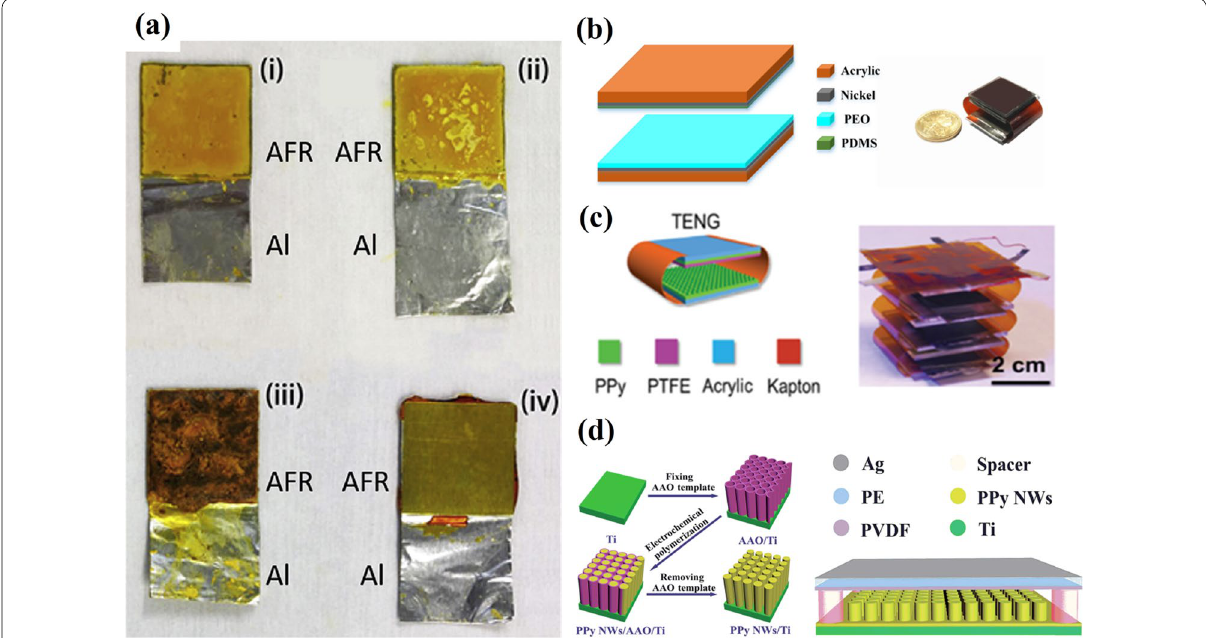
Fig. 3 Tribo-positive polymers for the TENG fabrication: a the digital photographs of the AFR sample at various stages of preparation with (i) corresponding to as-prepared uncured sample deposited on an Al foil, (ii) corresponds to washed sample while (iii) and (iv) correspond to the dried and fully cured, hot-pressed AFR samples, respectively (Reproduced with permission from Ref. [31]), b a schematic diagram and a photo of the TENG using PEO and PDMS films as the positive and negative tribo-materials, respectively (Reproduced with permission from Ref. [33]), c a schematic diagram and a photo of three stacked PPy-based TENG (Reproduced with permission from Ref. [34]), d a schematic depiction of PPy NW preparation by electrochemical polymerization with AAO as the template and schematic diagram of the final TENG. (Reproduced with permission from Ref.